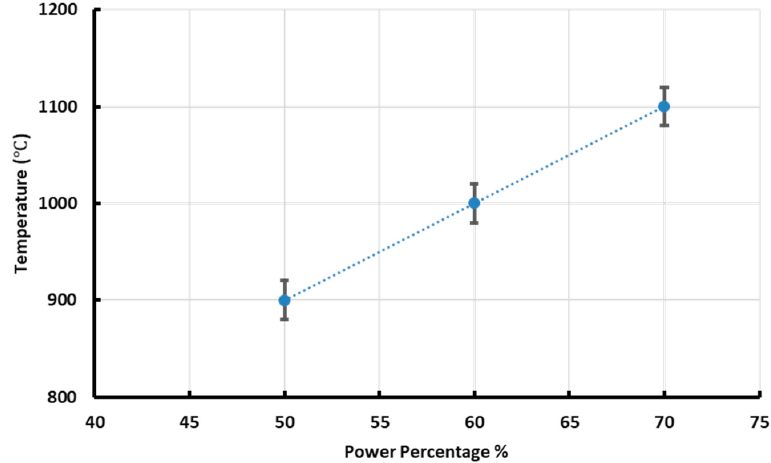
Figure 4. Temperatures at the center of the reactor cavity under different lamp power levels.